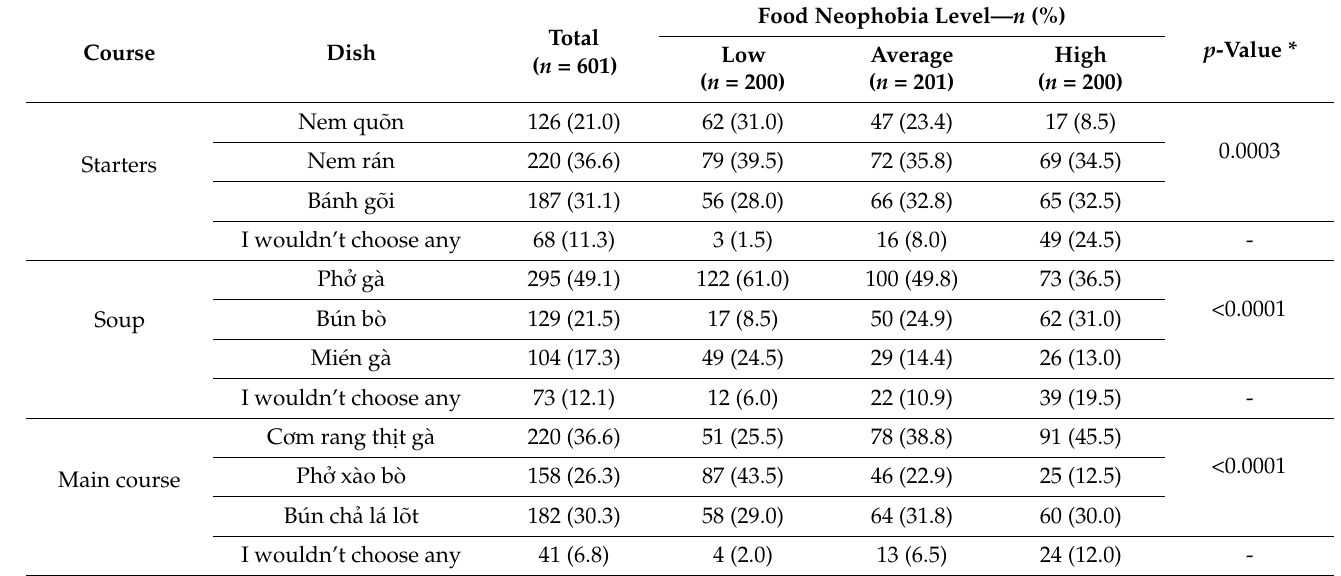
Table 5. The comparison of the choices of dishes from the Vietnamese model restaurant menu, stratified by food neophobia level of